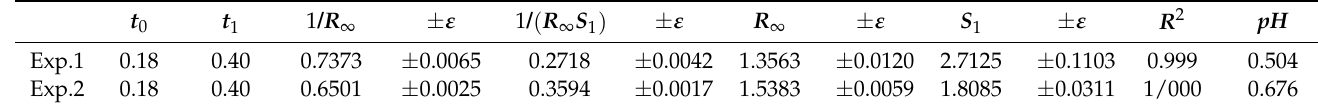
Table 7. Least squares fitting of the Azuara linear model parameters 1 (see Figure 12).